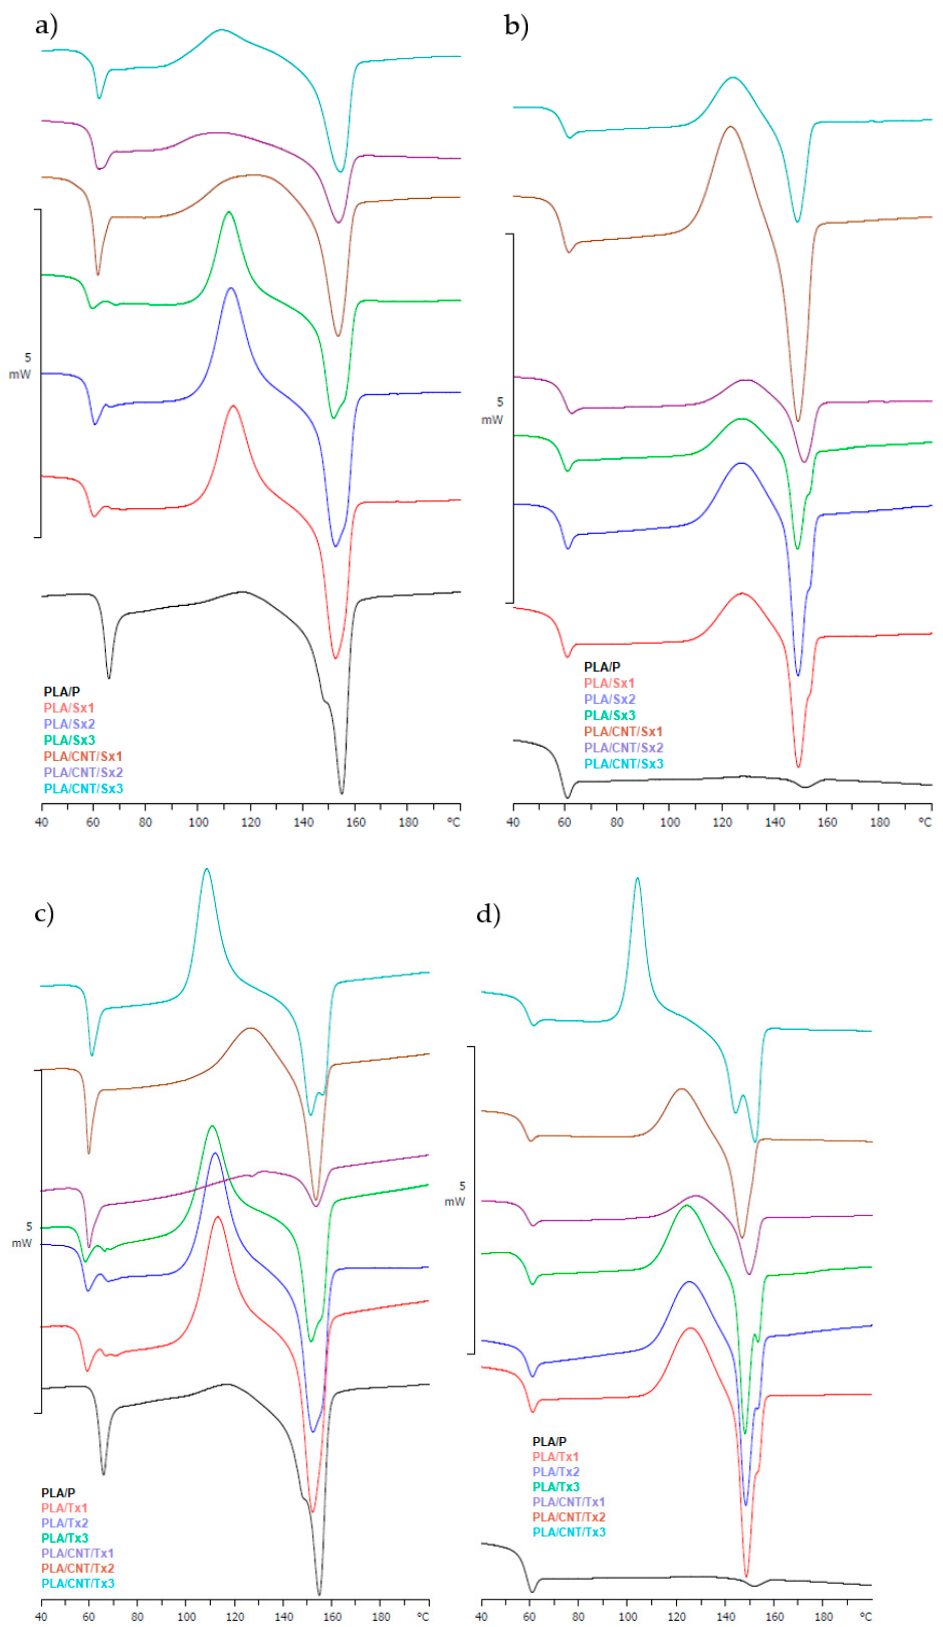
Figure 7. DSC analyses of composites produced by: single-screw extruder: ( a ) first heating and ( b ) second heating; twin-screw extruder: ( c ) first heating and ( d ) second heating.